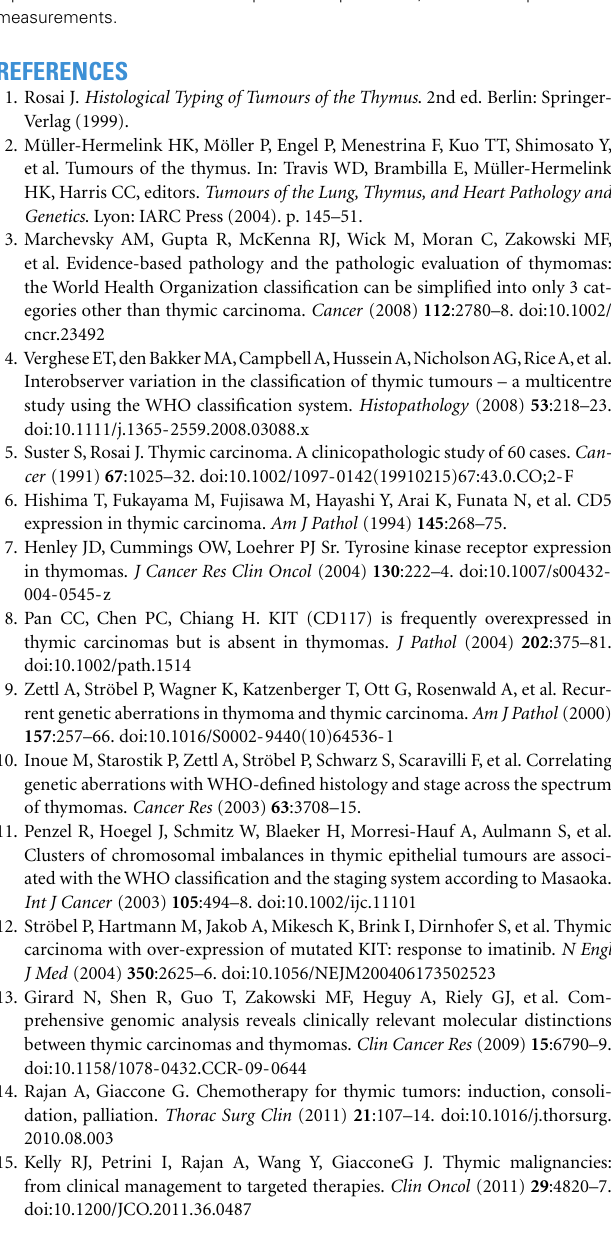
be differentially expressed on microarray analysis and are depicted in Figure 3 and Figure S1 in Supplementary Material . Figure S1 | Confirmation and validation of cKIT gene expression using qRT-PCR inTSCC . Figure S2 | Semi-quantitative determination of BIRC3 mRNA levels in several cell lines using standard PCR with 10ng cDNA as template for each sample . BIRC3 expression was detectable in all cell lines except the rhabdomyosarcoma cell lines RH30 and CRL2061. GAPDH was used as control. Figure S3 | Evaluation of annexinV-FITC/PI labeled cells using FACS 48h after BIRC3 knock-down .The transfected 1889c thymic carcinoma cells showed the highest level of apoptosis (50%) compared to HaCat (40%),TE167 (10%, ** p = 0.0097), A459 (20%, * p = 0.0432), PC3 ( < 10%, ** p = 0.0082), MCF7 ( < 20%, * p = 0.0154), and HeLa ( < 10%, ** p = 0.0079).The results represent the mean of three independent experiments, each with duplicate